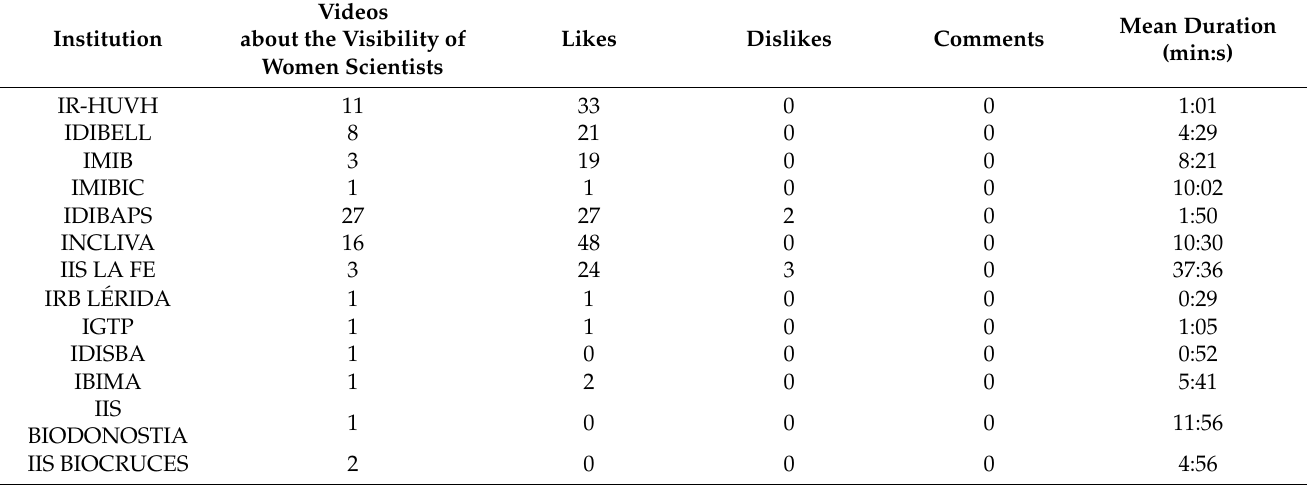
Table 2. Interaction of the user with the content about the visibility of women